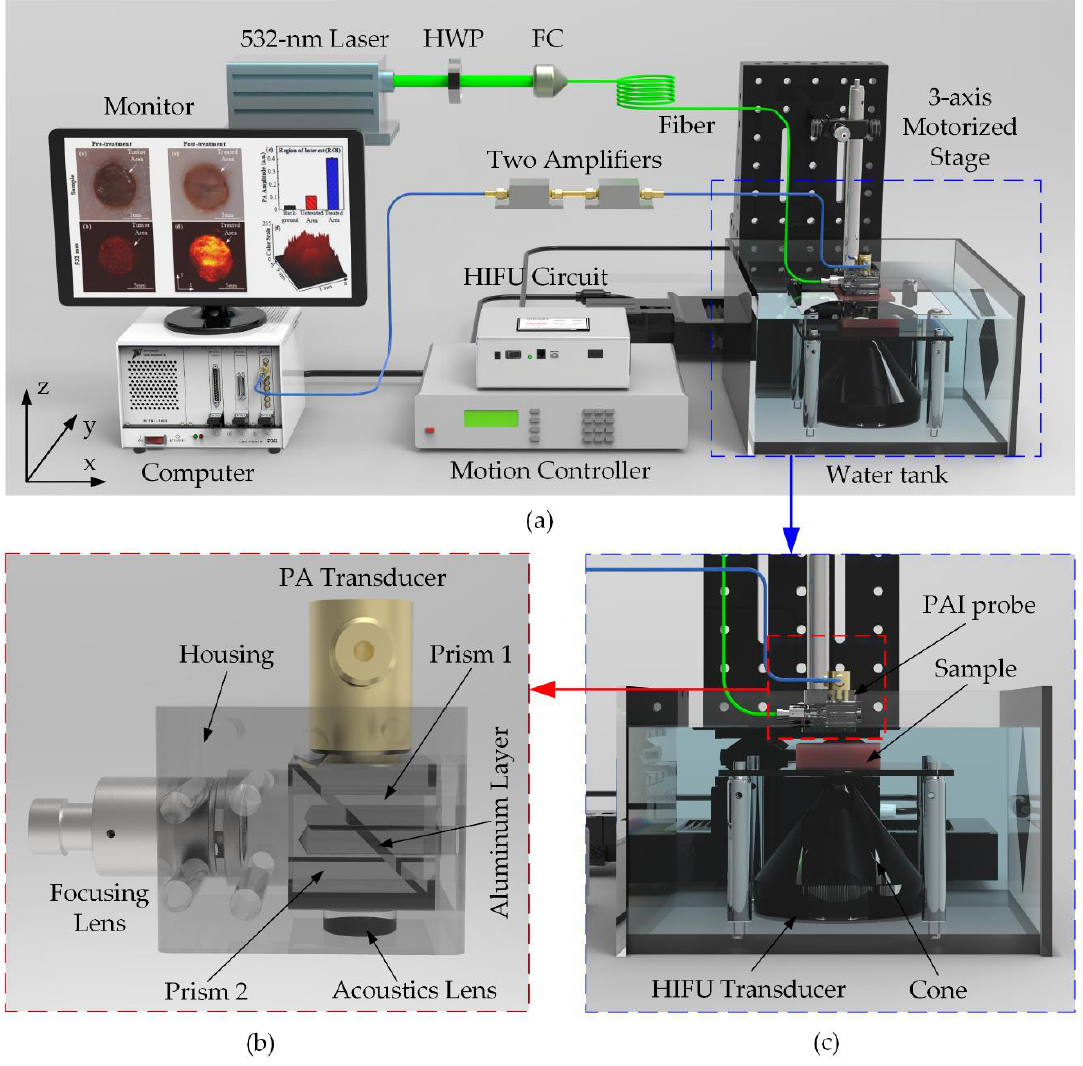
Figure 5. Ex vivo HIFU experiment integrated with PAI system for artificial breast tumors treatment ( a ) System schematic diagram. HWP: Half-wave plate; FC: Fiber Coupler ( b ) Self-made PAI probe ( c ) Close-up of the blue-dash operating region.